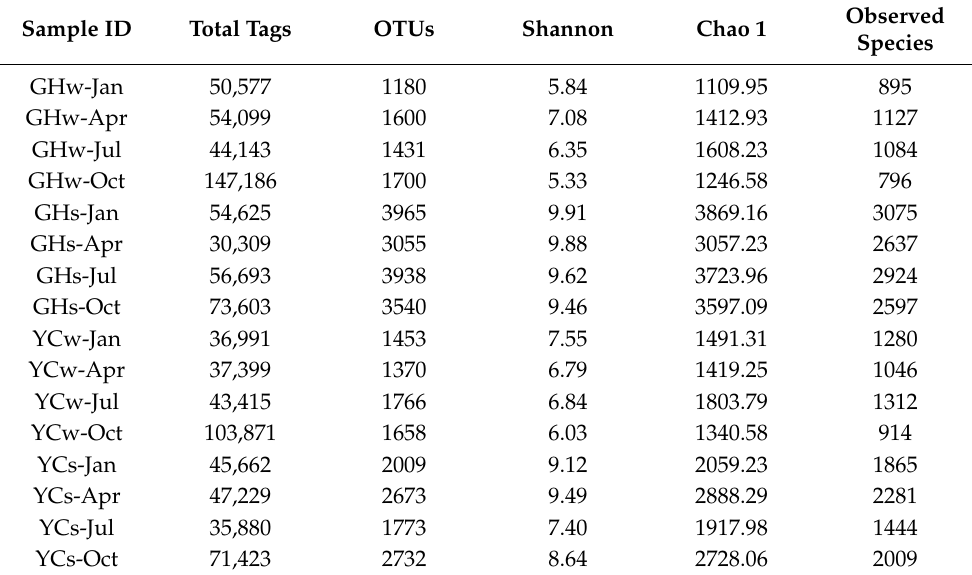
Table 3. Alpha diversity indices of microbial communities in the surface water and mud